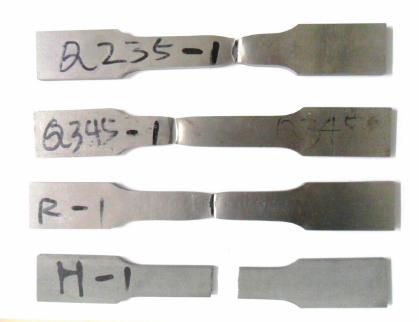
Figure 5: Fracture